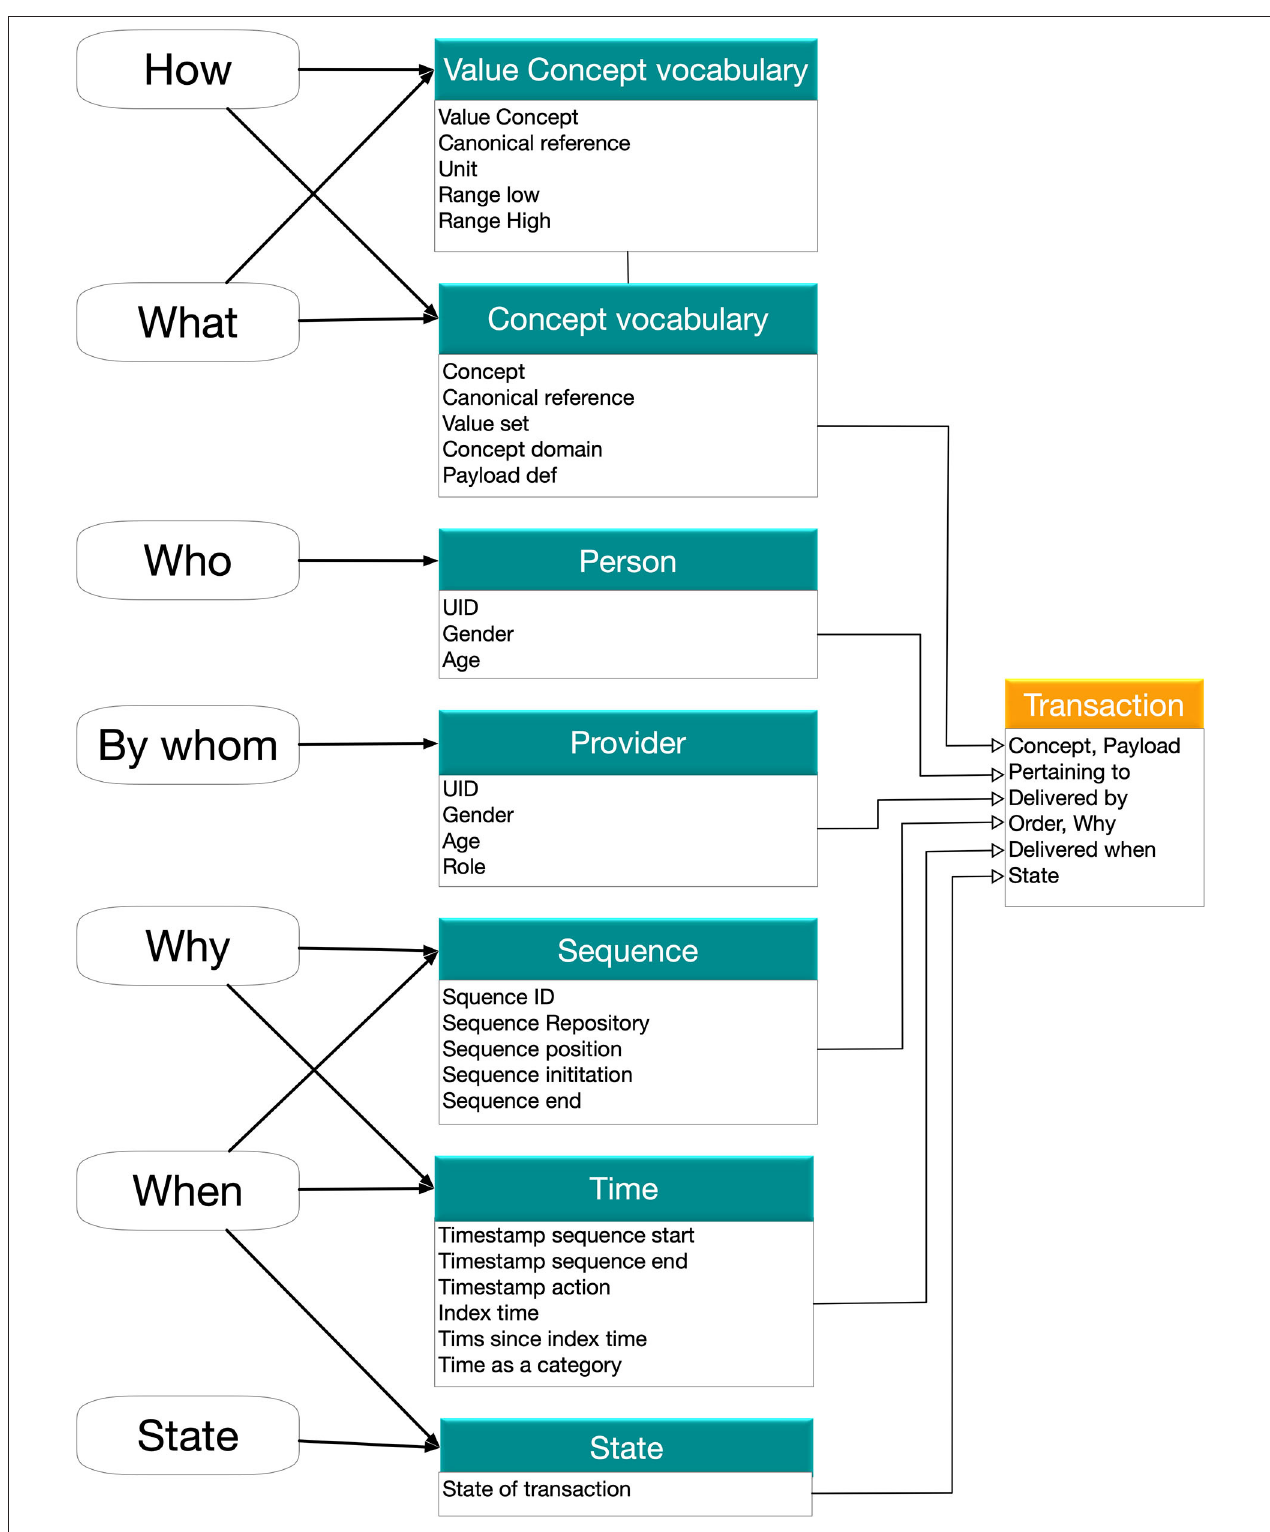
FIGURE 2 | The information model for the single transaction that represents the lowest level of analysis. The necessary semantic dimensions are represented in two levels with the concept level (What/How/Who) and the sequencing level (By whom, why, when, state). All this can be represented in common standards such as FHIR Observation. The two-level model limits the need for the most complex SNOMED CT concepts (see text). A set of planned transactions with the state marked as planned and scheduling (times in the future) is the content of a careplan.